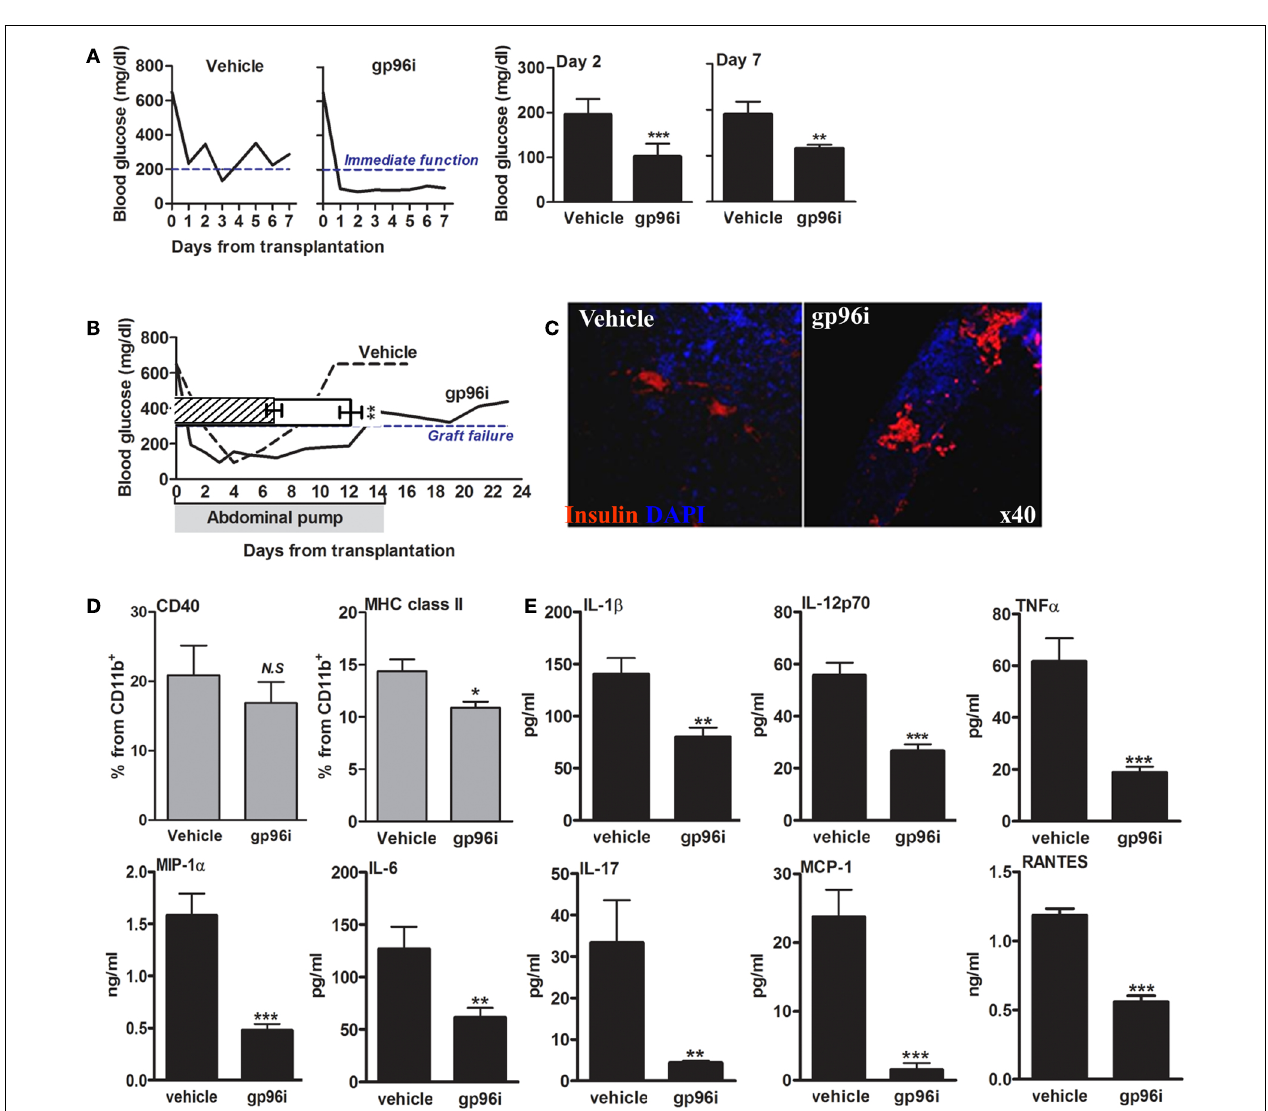
timeline over pooled results. Shaded, the 14-day time-frame of gp96i release. (C) Day-7 of explanted graft immunohistochemistry. Red , insulin; Blue , DAPI nuclear counterstaining. Representative images. (D) Activation markers. Spleen-derived macrophages (1 × 10 6 per sample) were stained for activation markers upon graft explanation on day 7. (E) Release of inflammatory mediators. Day-7 spleen-derived macrophages were cultured for 24h and supernatants were allowed to accumulate cell release products. Inflammatory mediators in the supernatants were measured by multiplex ELISA. Mean ± SEM, ** p < 0.01 and *** p <